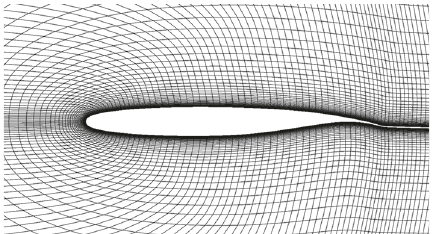
Figure 14: Closeup of the Navier–Stokes mesh optimized with curvature control functions but without orthogonality functions, showing the impact of curvature functions when compared to Figure